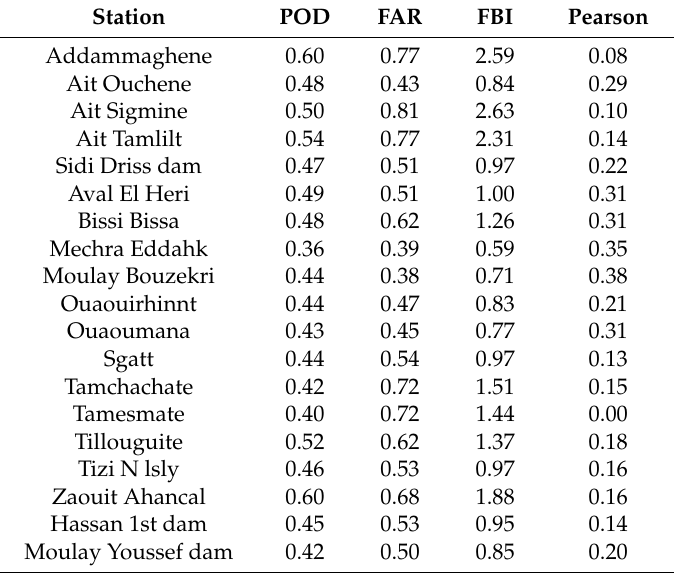
Table 2. Obtained statistics (POD, FAR, FBI, and Pearson correlation coefficient) for daily time scale. POD, Probability Of Detection; FAR, False Alarm Ratio; FBI, Frequency Bias Index. Station POD FAR